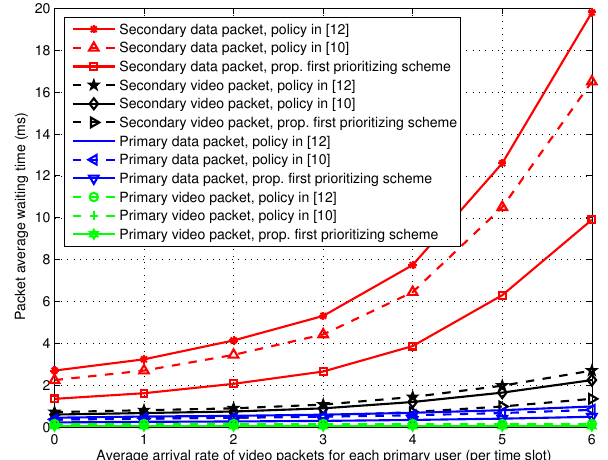
Figure 5. Average waiting time of the primary and secondary video and data packets for first prioritization scheme in our proposed scheme and the policy in